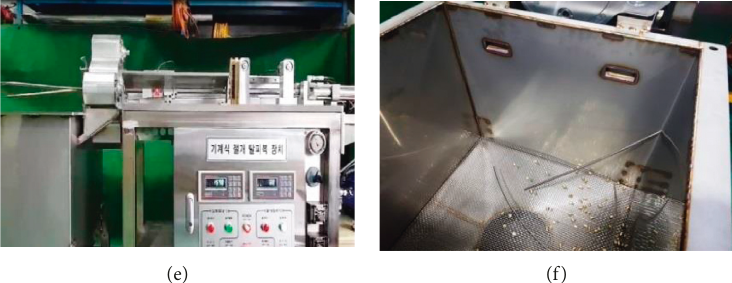
Figure 23: Mechanical decladding test of rod-cut: (a) seating, (b) extrusion, (c) discharge, (d) decladding, (e) falling, and (f) collection.